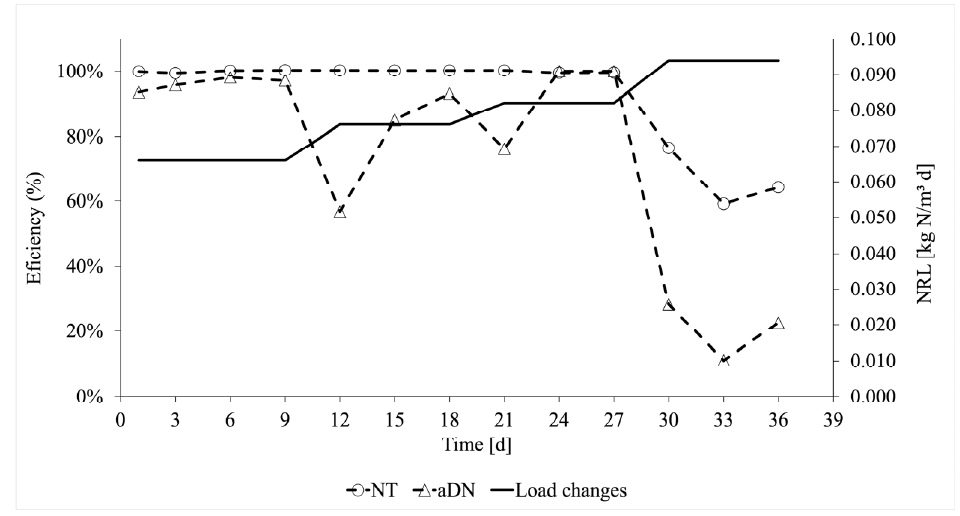
Figure 6. Results of the sequential aDN process. Nitrification (NT) and Autotrophic denitrification (aDN) efficiencies in R0.